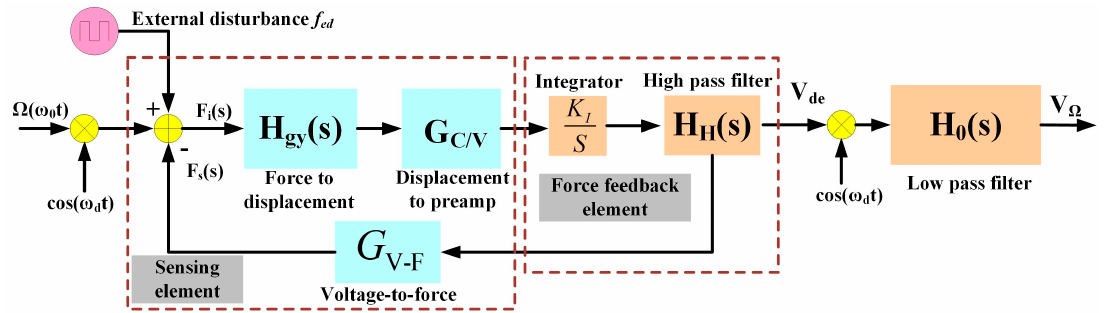
Figure 3. Transfer function of the sense-mode force feedback control system.